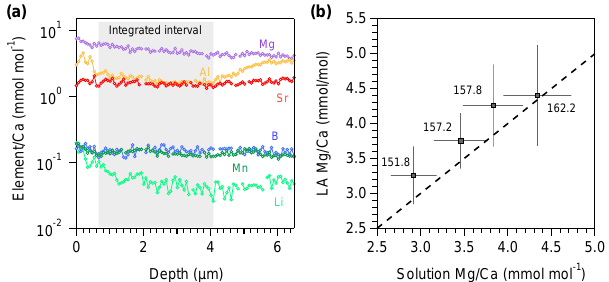
Figure 3. Panel (a) : an example laser-ablation profile trough a Tur- borotalia ampliapertura chamber. Sub-micrometre variations in el- ement / Ca ratios are identifiable, enabling poorly preserved or con- taminated areas of the test to be excluded from the calculation of mean values. Here, the inner and outer surfaces of the chamber are characterised by elevated Al / Ca, implying incomplete clay par- ticle removal. Panel (b) : a comparison of laser-ablation and solu- tion ICPMS Mg / Ca data from the same intervals at St. Stephens Quarry. Solution data from Wade et al. (2012). Labels show the depth intervals of these samples. Solution ICPMS error bars are the long-term precision (relative standard deviation, RSD), whereas laser-ablation error bars are 2 SE of all analyses from each